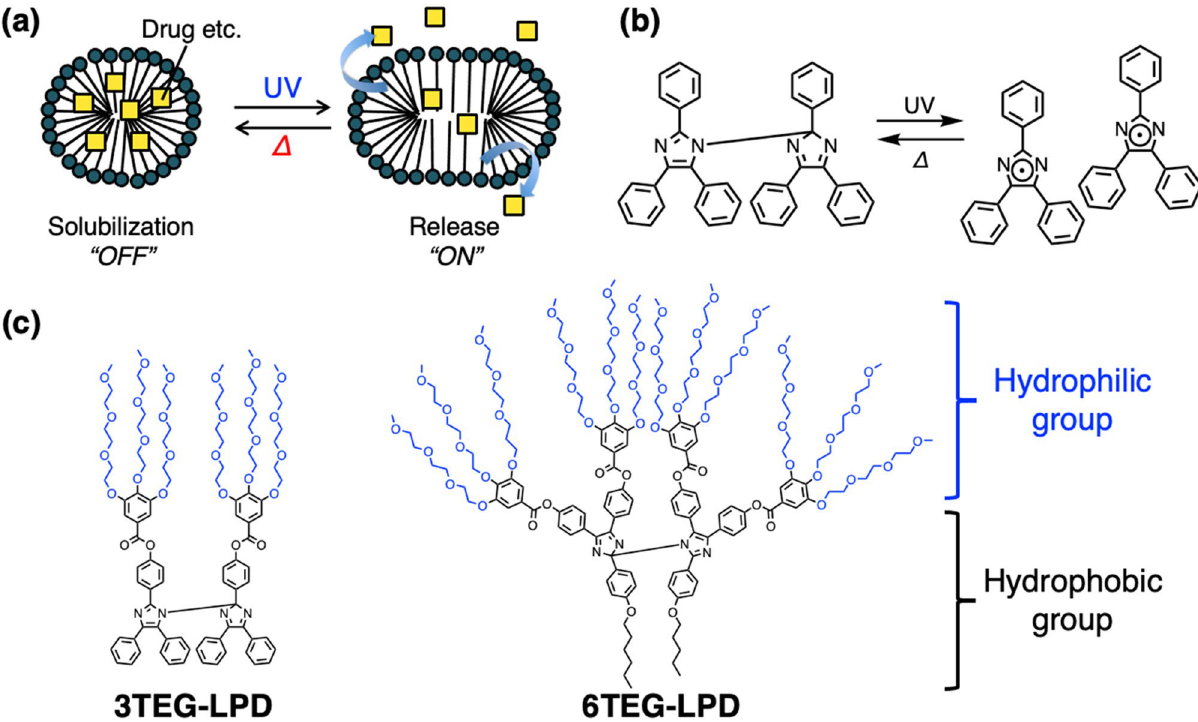
Figure 1. ( a ) Schematic image of controlled release with a photoresponsive molecular assembly. ( b ) Photochromism of the lophine dimer. ( c ) Chemical structures of the amphiphilic lophine